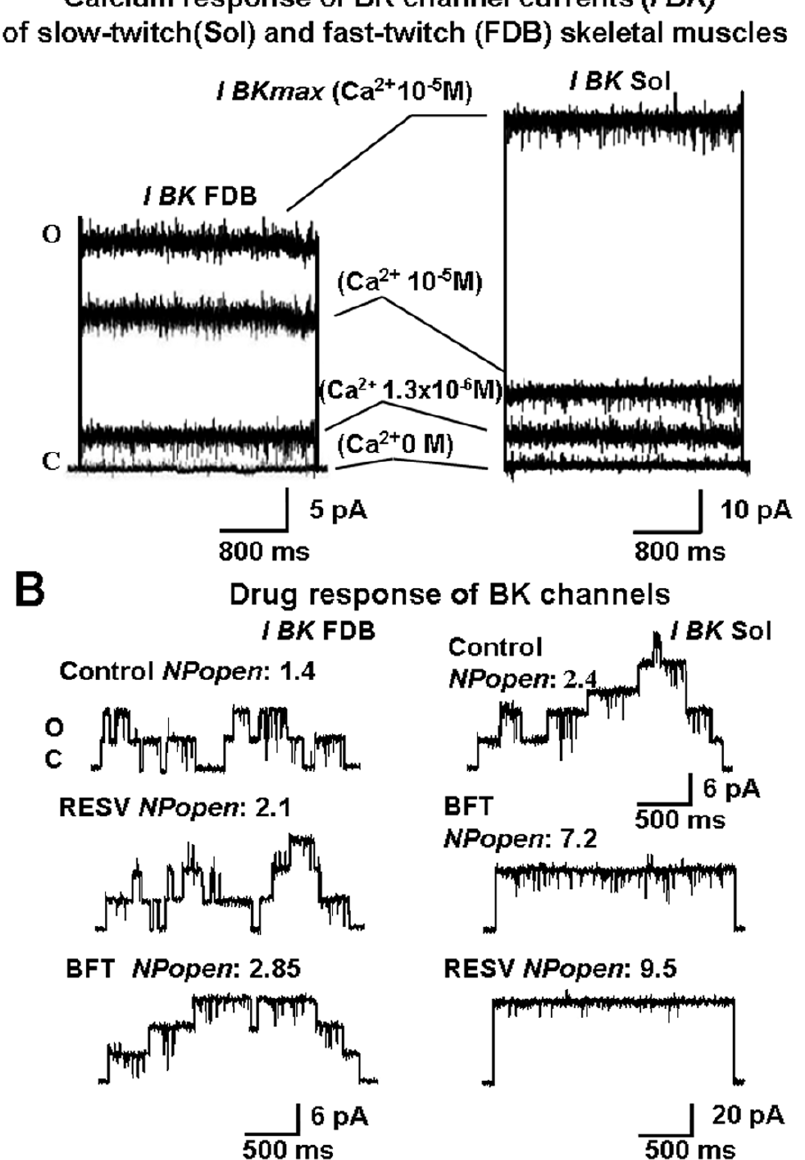
Figure 4. Calcium response and drug response of Ca 2 + -activated K + channels (BK) of flexor digitorum brevis (FDB) and soleus (Sol) fibers. (A–B) Currents were recorded during voltage steps from 0 mV holding potential, prepulse of 2 70 mV, to 2 80 mV and + 80 mV (Vm) in excised macropatches with 150 mM KCl on both sides of the membrane patches and in the presence of increasing calcium concentrations in the bath. Upward deflection in the current record indicates outward currents recorded at + 30 mV or + 80 mV (Vm); downward deflection indicates inward currents recorded at 2 60 mV (Vm). C, closed channel level; O, open channel level. The currents were leak-subtracted. (A) The represented BK channel current traces of FDB and Sol fibers were obtained by an ensemble average of 16 and 18 sweeps (1 sweep/voltage membrane/patch) from 16 and 18 patches for each FDB and Sol muscle, respectively. Channel currents were recorded in the FDB and Sol fibers using pipettes of 1.9 6 0.6 MOhm and 2.1 6 0.4 MOhm resistance, respectively. The Ca 2 + response of the channels was evaluated at + 30 mV (Vm) in the presence of increasing concentration of internal Ca 2 + ions from 0 M to 1.3x10 2 6 M and 10 2 5 M. The recorded currents were than normalized to I BKmax which is the maximal BK current recorded at + 80 mV (Vm) in the presence of 10 2 5 M concentration of free Ca 2 + ions. A maximal BK channel activation of 80% was observed in the FDB fibers in these patches in the presence of 10 2 5 M concentration of Ca 2 + ions, whereas no more than 15% activation of the BK channel current was observed in Sol fibers in the presence of 1.3x10 2 6 M and 10 2 5 M concentrations of Ca 2 + ions indicating that the BK channel population in FDB fibers was more sensitive to Ca 2 + ions than those of Sol fibers. (B) BK channel current response to resveratrol (RESV) (2x10 2 4 M) and bendroflumethiazide (BFT) (2x10 2 4 M) recorded in fibers from FDB and Sol muscles. Single channel currents were recorded in the FDB and Sol fibers using pipettes of 3.2 MOhm and 3.4 MOhm resistance, respectively. Single channel transitions were observed in the FDB and Sol fibers at + 30 mV (Vm) in the presence of 10 2 5 M free Ca 2 + ions. The N Popen was higher in the Sol fiber as compared with that recorded in the FDB fiber, the number of functional channels in the patches were 3 in the FDB fiber and 5 in the Sol fiber. No difference was observed in the single channel current between the FDB and Sol fibers. The application of RESV and BFT increased the N Popen of the channel without affecting single channel current. In the FDB fiber, BFT was more effective as BK opener than RESV, whereas RESV was more effective than BFT in the Sol fiber.